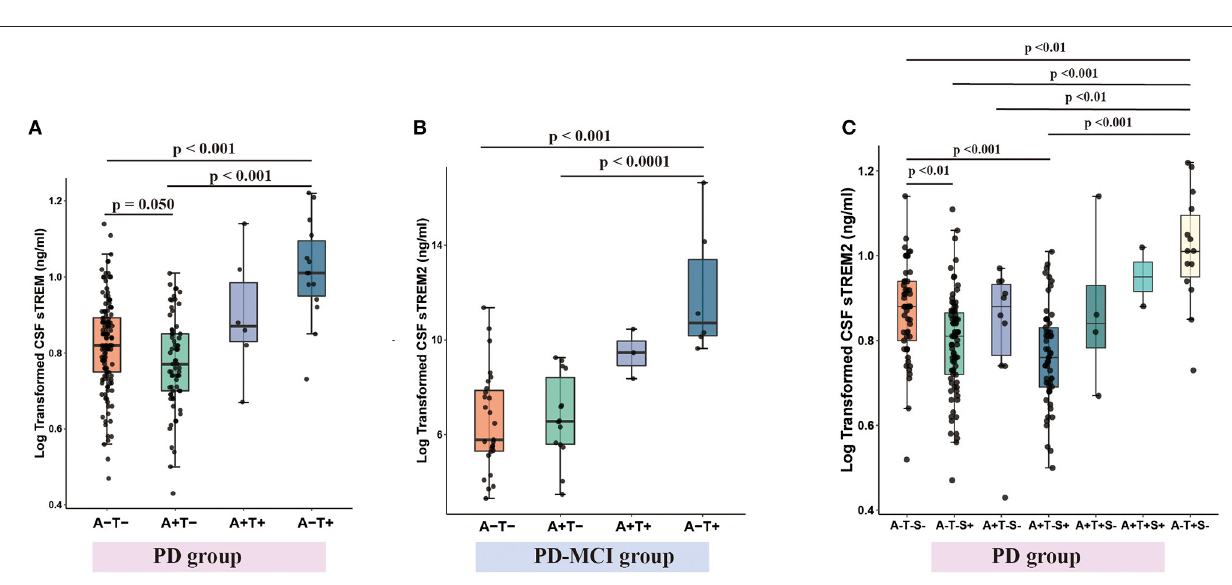
FIGURE 5 | CSF sTREM2 levels within A/T classification framework with or without CSF α -syn (S) in PD group. CSF sTREM2 was lowest in A-T- group and highest in A-T + group in PD group (A) . CSF sTREM2 was highest in tau pathology in PD-MCI group (B) . With the addition of CSF α -syn (S) to A/T framework, CSF sTREM2 was lowest in A + T-S + group, then higher in A-T-S + group, and highest in A-T + S- group (C) . p -values were assessed by a one-way ANCOVA, and significant p -values after Bonferroni corrected post-hoc pairwise comparisons are marked. CSF, cerebrospinal fluid; sTREM2, soluble triggering receptors expressed on myeloid cells 2; PD, Parkinson’s disease; A + , A β pathology (defined as low CSF A β 1–42); T + , tau pathology (defined as high CSF P-tau); S + , α -syn pathology (defined as low CSF α -syn); PD, Parkinson’s disease; MCI, mild cognitive